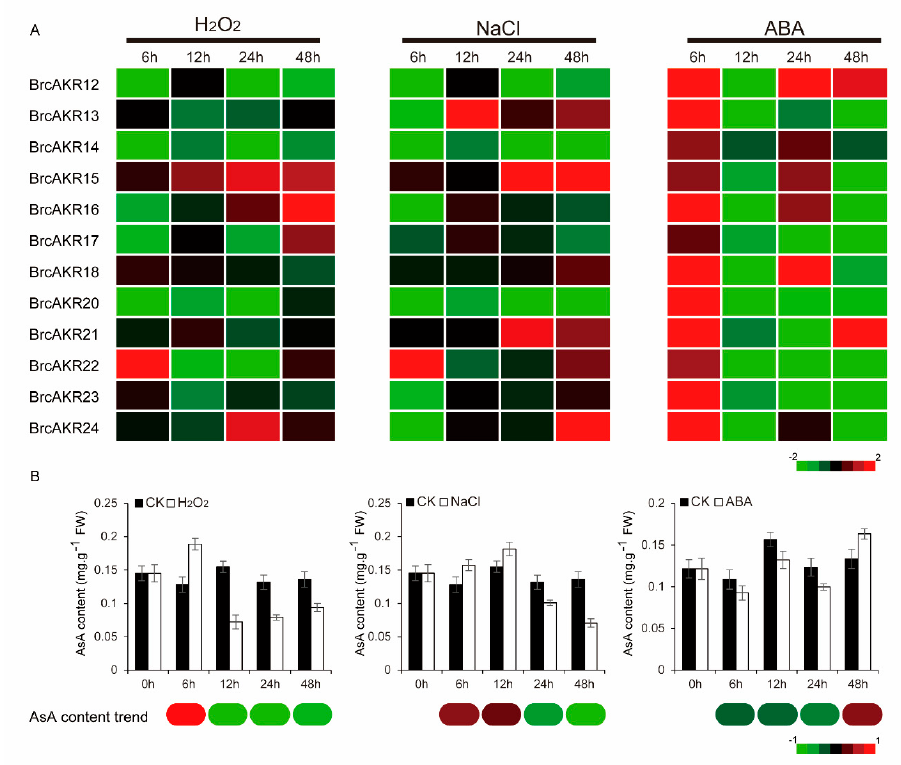
Figure 5. Expression of aldo-keto reductases ( AKR ) genes and ascorbic acid (AsA) content level under NaCl, H 2 O 2 , and abscisic acid (ABA) treatments in Pak-choi leaves. ( A ) Transcript level analysis of AKR genes. ( B ) AsA content level. The bar at the bottom of each heat map represents the relative values.